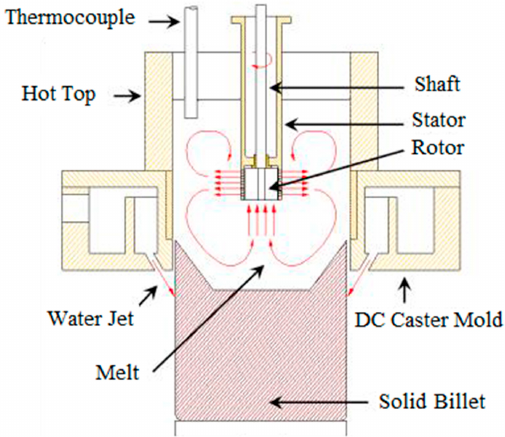
Figure 1. Schematic diagram of the melt conditioned direct chill casting (MC-DC) with the rotor-stator shearing device submerged in the sump of a conventional DC casting mold [1]. Chemical segregation, hot tearing, porosity and non-uniform microstructure are the main defects in direct chill casting [17]. In this work, AA6111 billets were produced by using both the MC- DC casting technology and by conventional grain refinement (DC-GR) followed by extrusion and rolling. The aim of this study was to assess the microstructure and tensile properties of AA6111 automotive body-sheet formulated from TT scrap. The end-of-life (TT) scrap was processed into billets in direct chill casting followed by extrusion process, cold rolling, heat treatment, and paint bake simulation. 2. Experimental Procedures 2.1. Billets Casting and Extrusion For direct chill casting with and without high shear melt conditioning (HSMC), three batches of TT scrap (A052, F255 and F256) were received as RSIs from Norton aluminum (Cannok, UK). To match the target AA6111 composition, the first batch of TT (A052) was melted and formulated by adjusting Cu and Mg level only. The other two batches of TT (F255 and F256) were melted and alloyed with Cu, Mg, Mn, Cr, and Zr. The aim of adding recrystallization inhibitors Mn, Cr, and Zr to TT- 6111 was to minimize the development of a coarse outer band of recrystallized grains during extrusion. Table 1 lists the chemical composition of the as-received Taint Tabor batches after re- melting at Norton aluminum, the formulated TT-6111 (1, 2 and 3) alloys and the target AA6111 compositions. Table 1. Compositions of as-received TT ingots, formulated TT-6111 and target AA6111 alloys. Wt. %